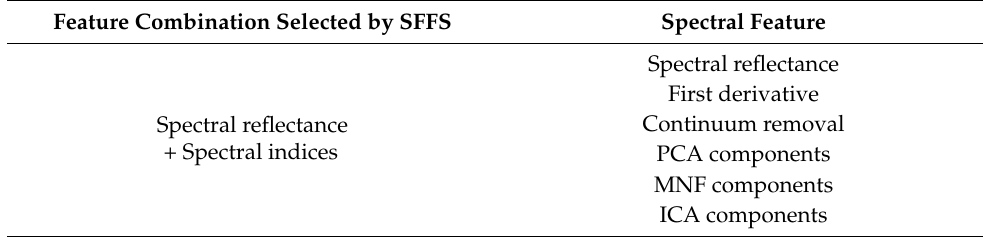
Table 4. Scenarios used for classification based on multispectral